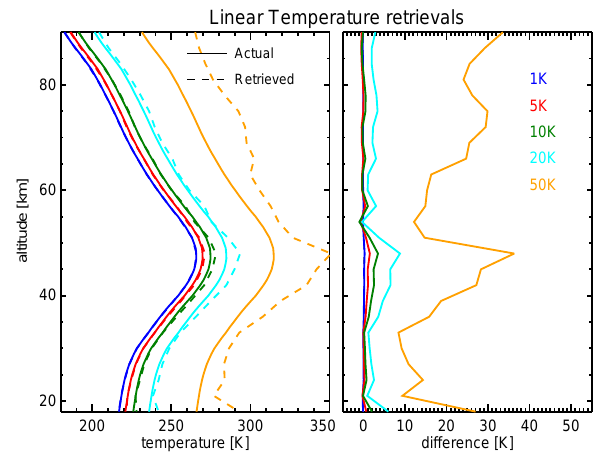
Fig. 2. Linearly retrieved pressure for different increments of the entire pressure profile (left) and percentage difference between the actual and retrieved values (right). Fig. 3. Linearly retrieved temperature for different increments of the entire temperature profile (left) and absolute difference between the actual and retrieved values (right).